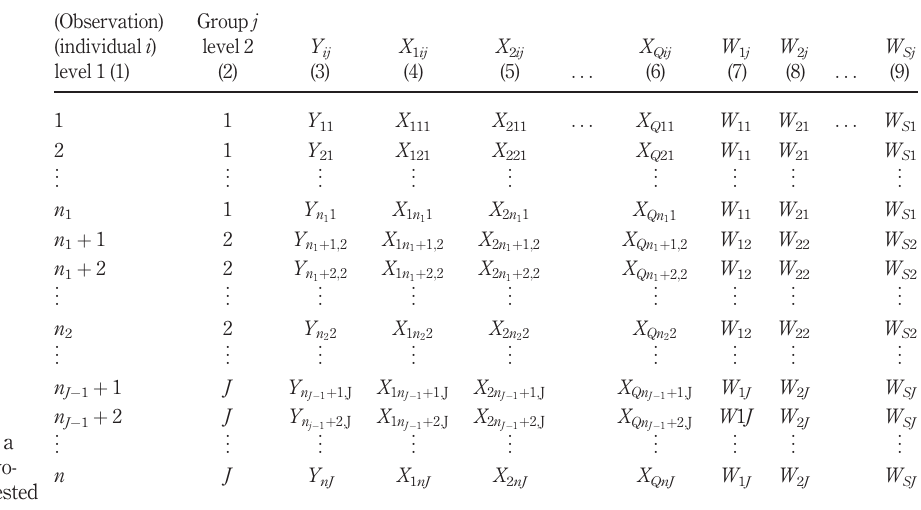
Table I. General model of a dataset with a two- level clustered/nested data